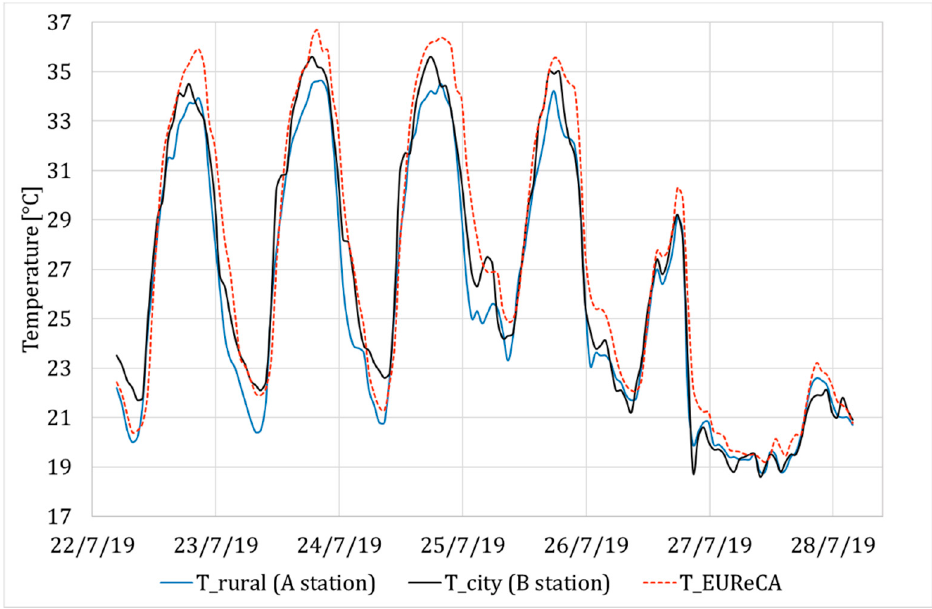
Figure 6. Hourly air temperature in some July days. Comparison between rural measured data ( B station ), city center measured data and simulated temperature (urban weather generator (UWG) air node).